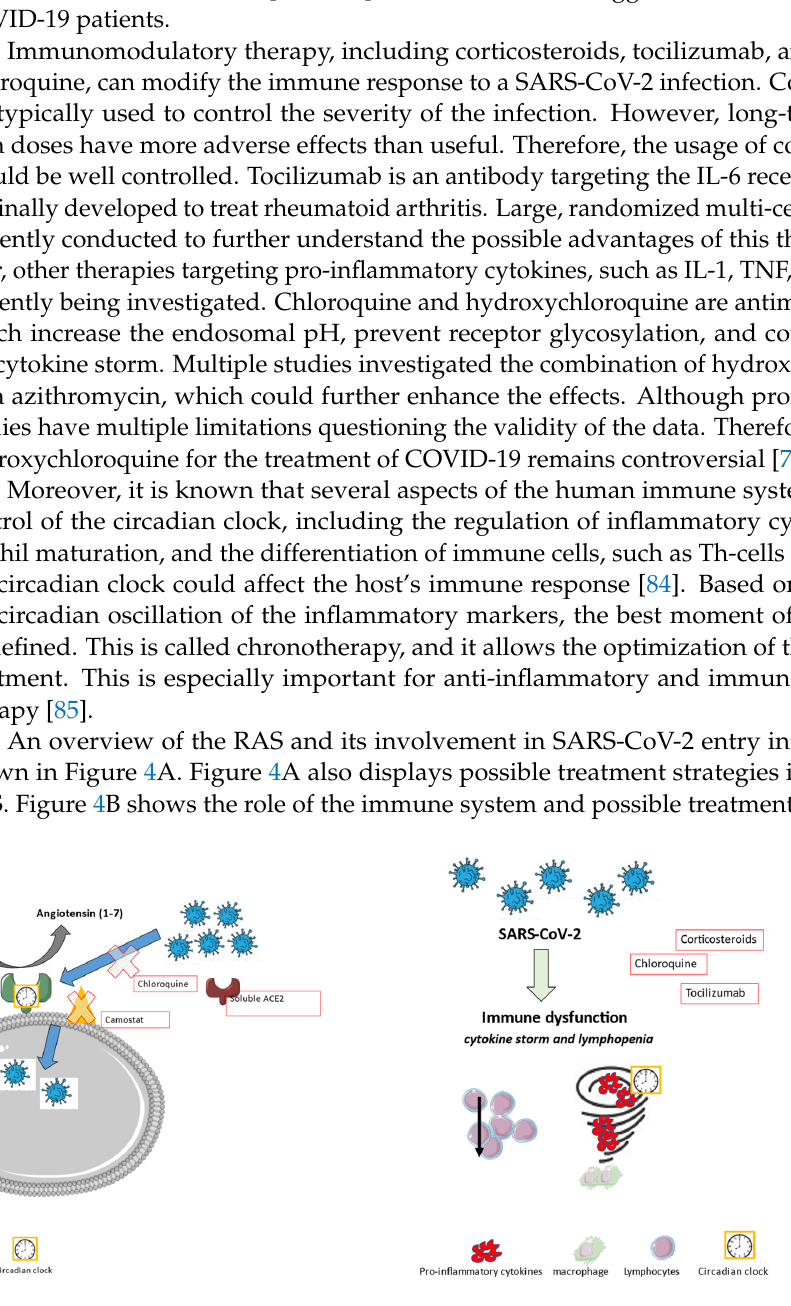
This has been attributed to inflammation and the nicotinic cholinergic system. First, smok- ing and COPD induce inflammation, which can cause an upregulation of ACE2. Secondly, nicotine itself was shown to increase the ACE2 expression in human bronchial epithelial cells. This effect was reduced after the administration of alfa-bungarotoxin, a nicotinic acetylcholine receptor (nAChR) antagonist [90]. Additionally, the gene expression of ACE2 showed a positive correlation with the gene for the nicotinic Alpha 7 subunit of the cholinergic receptor (CHRNA7) (Pearson correlation coefficient of 0.54) [91]. This points further to a direct role of nicotine in the upregulation of ACE2. The higher enzymatic ac- tivity of ACE2 after nicotine administration reduces the amount of angiotensin II in favor of Angiotensin (1–7) [92], which will then promote the anti-inflammatory pathways. Moreover, the administration of nicotine could stimulate the cholinergic anti-inflamma- tory pathway through the alfa7-nAchR and the vagal nerve [93,94]. This points to a role for nicotine or nicotinic receptor agonists in the treatment of inflammatory diseases, in- cluding viral infections such as COVID-19. Additionally, nicotine itself can act as a competitive antagonist for the direct interac- tion of SARS-CoV-2 with the nAchR. It has been proven that an amino acid sequence in the receptor-binding domain of the spike protein of SARS-CoV-2 is similar to alfa-bunga- rotoxin and therefore is a good match for the alfa 7 and alfa 9 receptor [95]. The SARS- CoV-2 interaction with the nicotinic receptor will inhibit the nicotinic cholinergic system and dysregulate the Angiotensin II/Angiotensin (1–7) balance in favor of the pro-inflam- matory status. The administration of nicotine could counteract this interaction and lower the angiotensin II expression. This further confirms that nicotine could form an interesting therapy to treat COVID-19. It needs to be noticed that the dominant negative duplicate CHRFAM7A, the human partial duplication of the CHRNA7 gene which encodes for the α 7nAchR, is decreased in patients with a more severe form of COVID-19. A reduced CHRFAM7A expression in- creases the ion channel function and stimulates the anti-inflammatory effect [96]. This needs to be taken into account when considering treatment strategies, as it has proven to